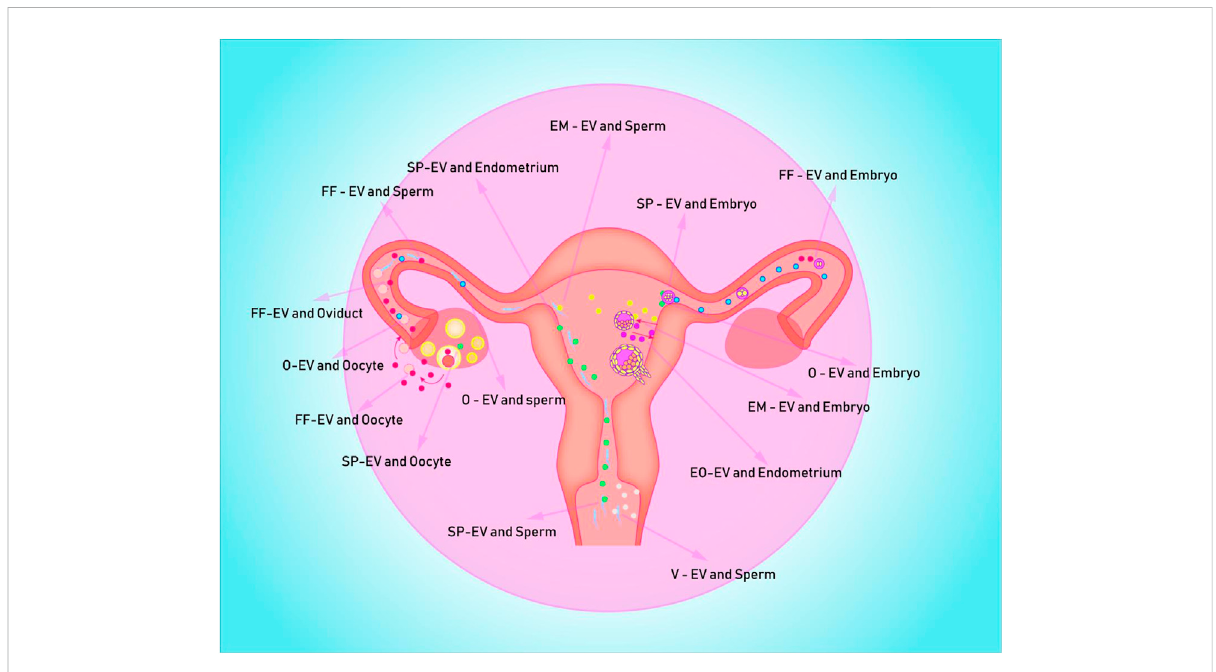
FIGURE 1 DepictspotentialEVsmessengerpathwaysinthehumanuterusforembryoformation,development,andimplantation.EVisrepresentedbythe colored spheres. (A) The blue ball is the O-EVs, which transports information from the oviduct to the oocyte, sperm, and early embryo; (B) The red sphere represents FF-EVs, which can communicate information from the follicle to the fallopian tube, sperm, and early embryo; (C) The white ball represents the V-EVs, which can transmit vaginal information to the sperm; (D) The green sphere represents the SP-EVs, which is capable of transmitting seminal plasma information to sperm, endometrium, and follicle; (E) The purple spheres are mostly EO-EVs, which can send data from the embryo to the maternal endometrium; (F) The yellow spheres represent EM-EVs, which transmit information from the endometrium to sperm and